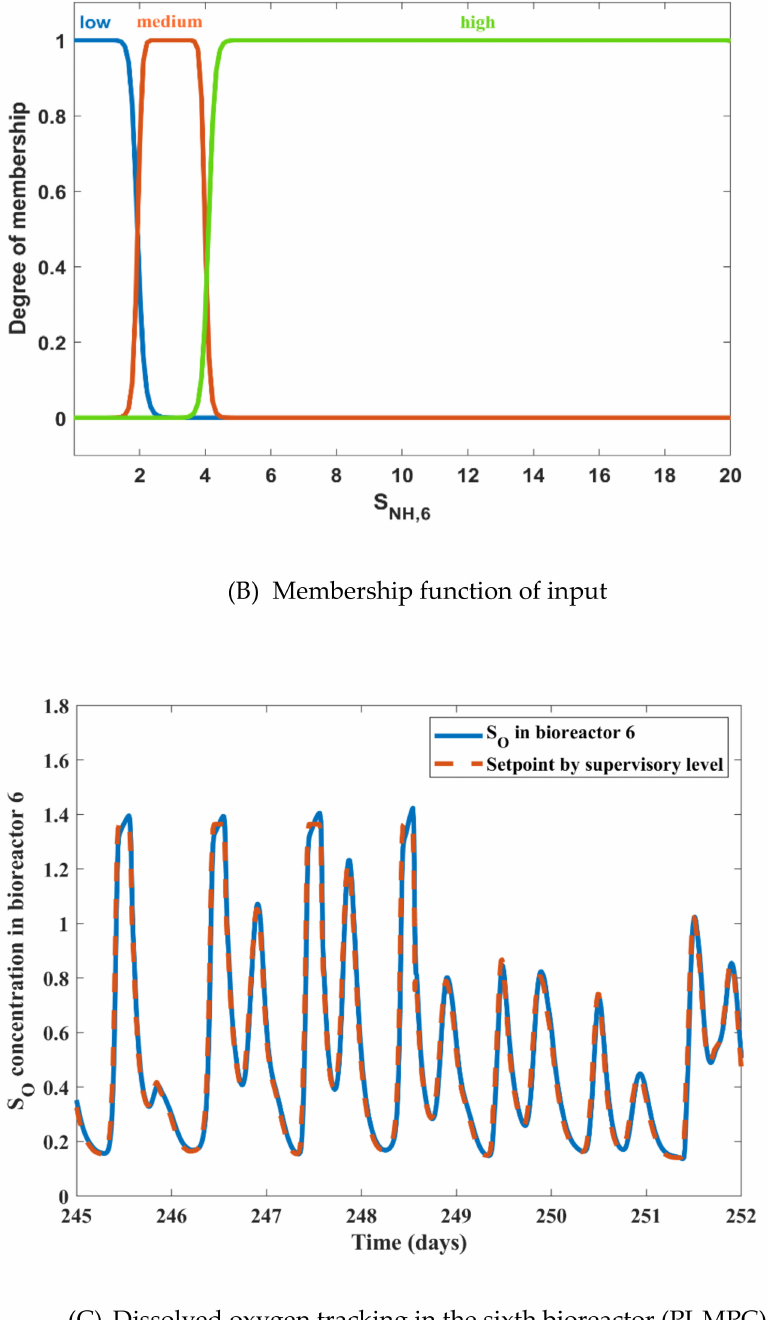
Figure 5. Membership functions rules: ( A ) Output, ( B ) Input, and ( C ) corresponding tracking